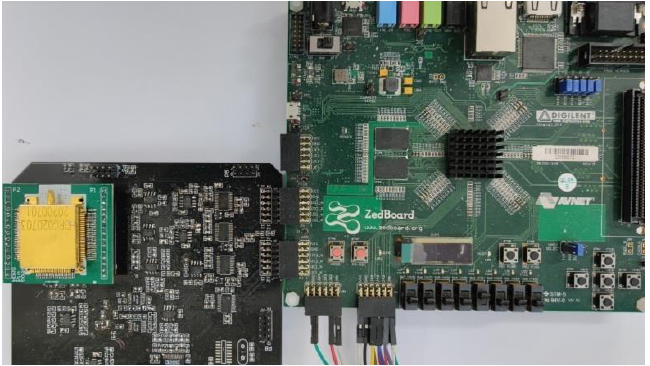
Figure 13. Gyro control circuit.